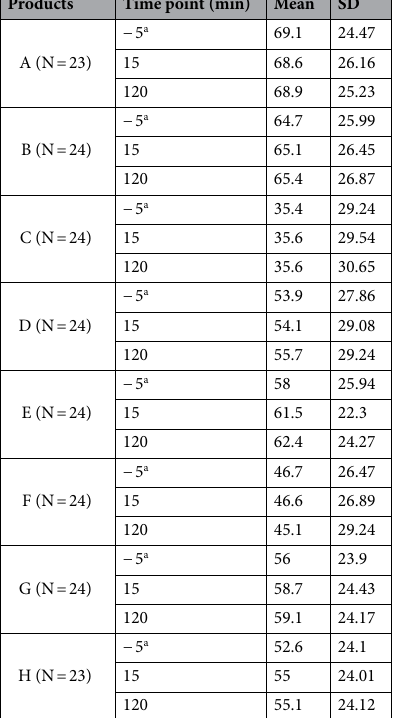
Table 4. Summary of subjective product liking. Products: A, combustible cigarette (ad libitum); B, combustible cigarette (fixed); C, ePen2.0BT18 (ad libitum); D, ePen3.0BT18 (ad libitum); E, ePen3.0MB18VP (ad libitum); F, ePen3.0MB30VP (ad libitum); G, ePen3.0MB18VP (fixed); H, ePen3.0MB12VP (ad libitum). SD standard deviation. a – 5 min was a nominal time point corresponding to product satisfaction evaluated at the familiarisation session.